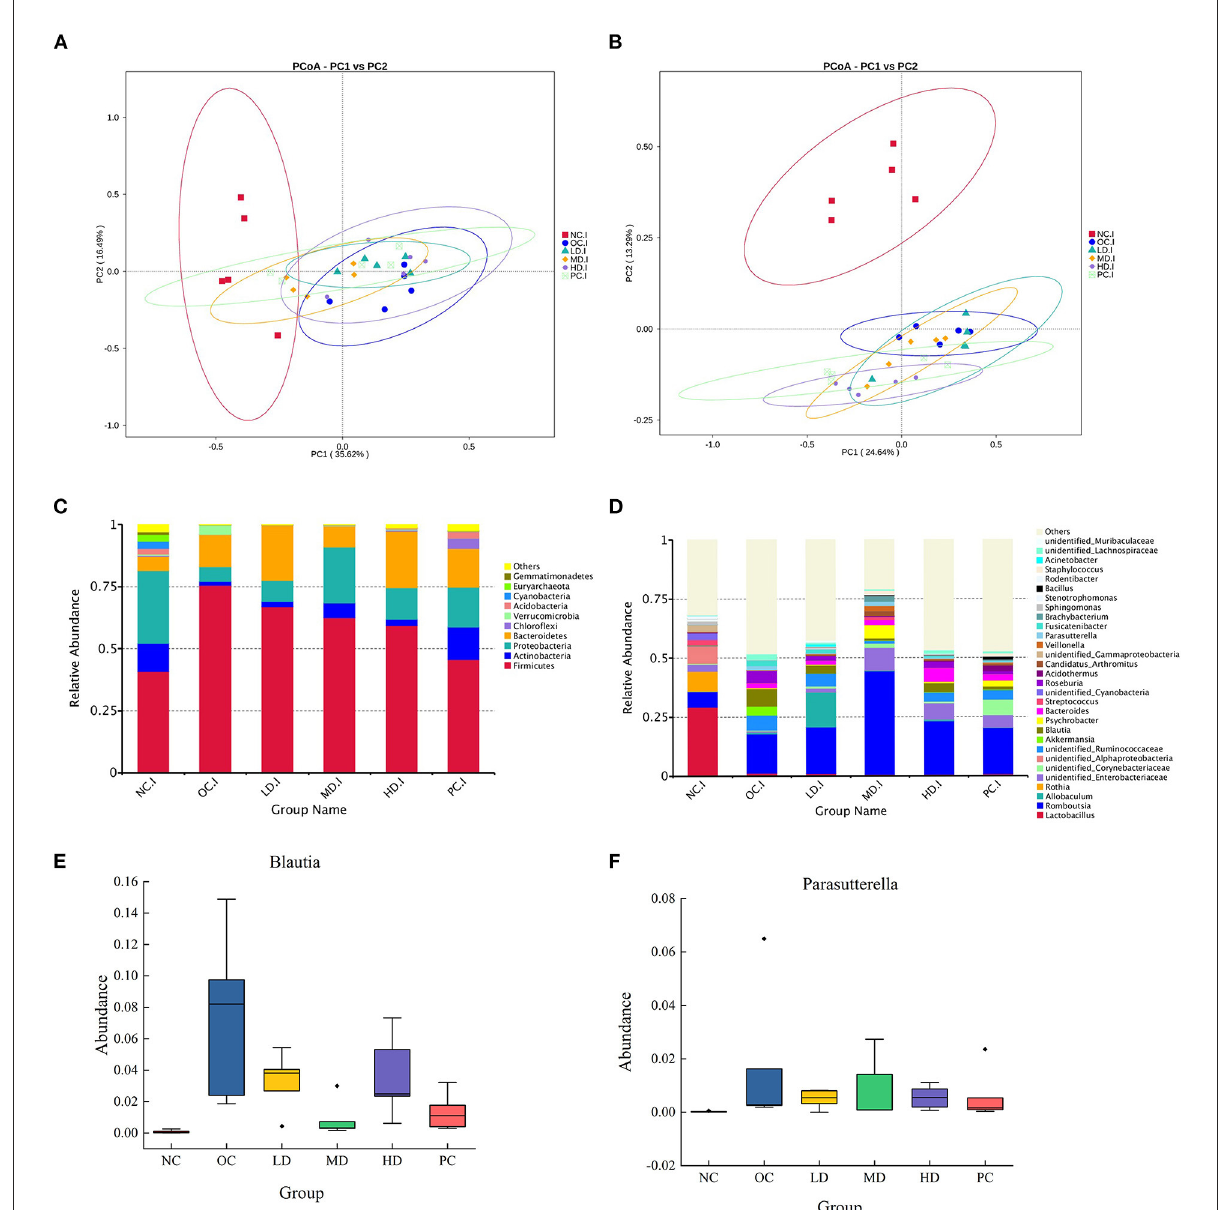
FIGURE2 Plantain administration alters the composition of gut microbiota (A) principal co-ordinates analysis (PCoA) of gut microbiota based on Unweighted Unifrac distance (B) principal co-ordinates analysis (PCoA) based on Weighted Unifrac distance (C) relative abundance of